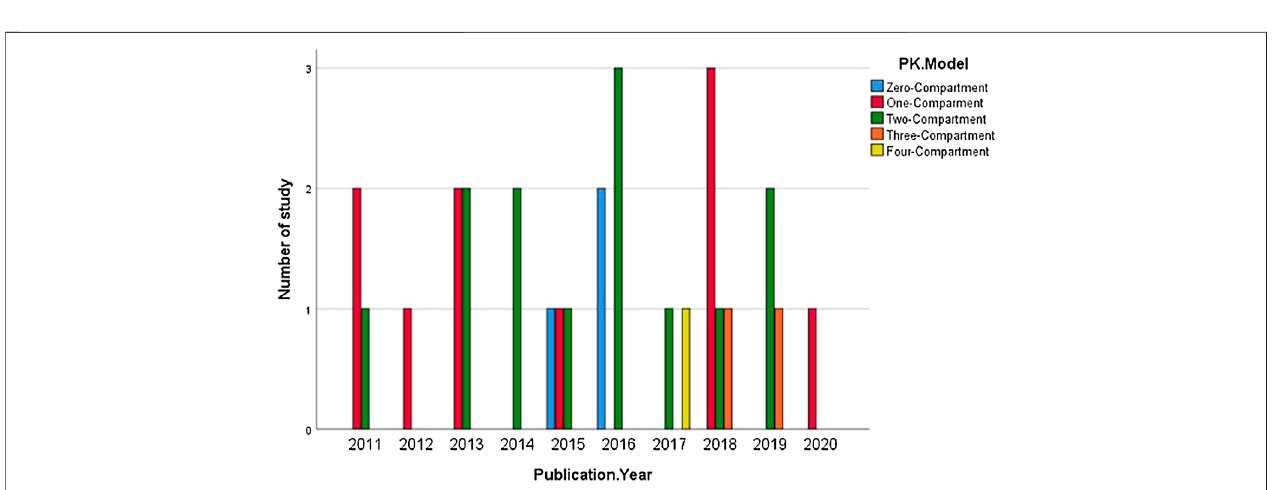
Frontiers in Pharmacology |